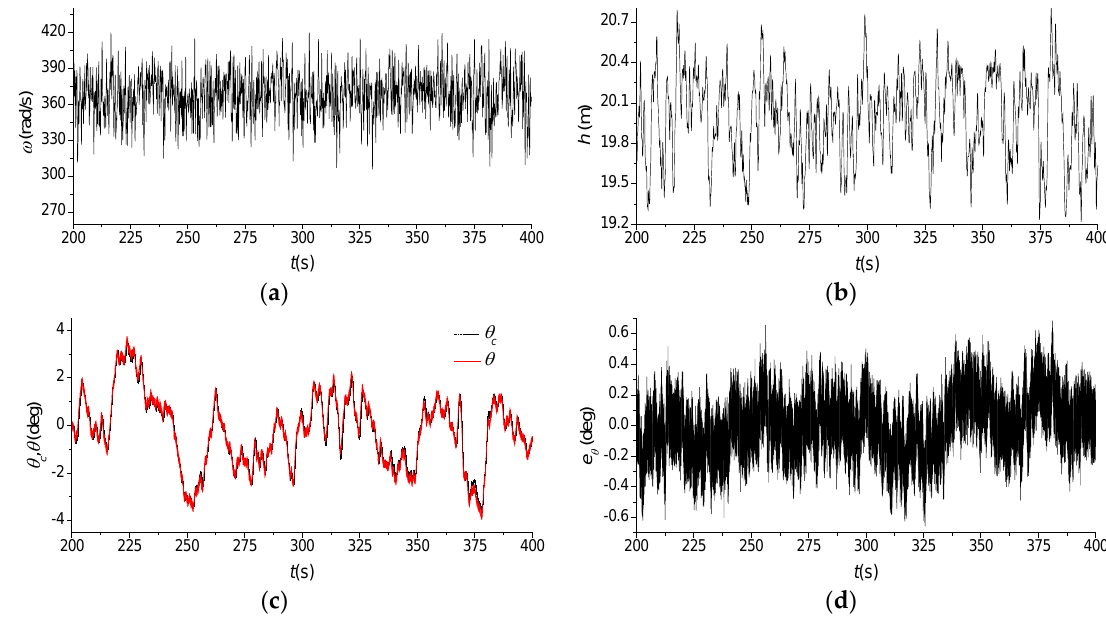
Figure 14. The experimental results using the PID controllers in the altitude loops, and the PID controller without the closed-loop rotational speed control structure in the altitude loop: ( a ) ω ; ( b ) h ; ( c ) θ c and θ ; ( d ) e θ